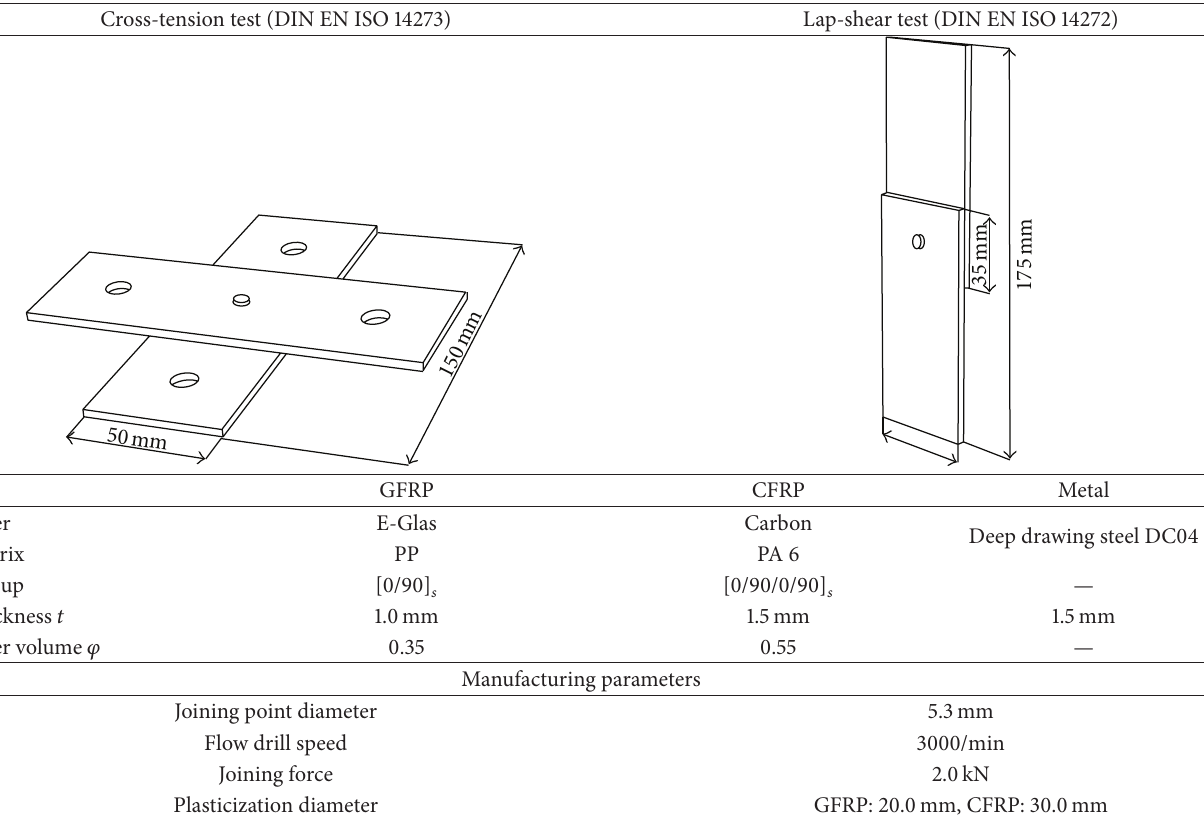
Table 1: Specification of tests and